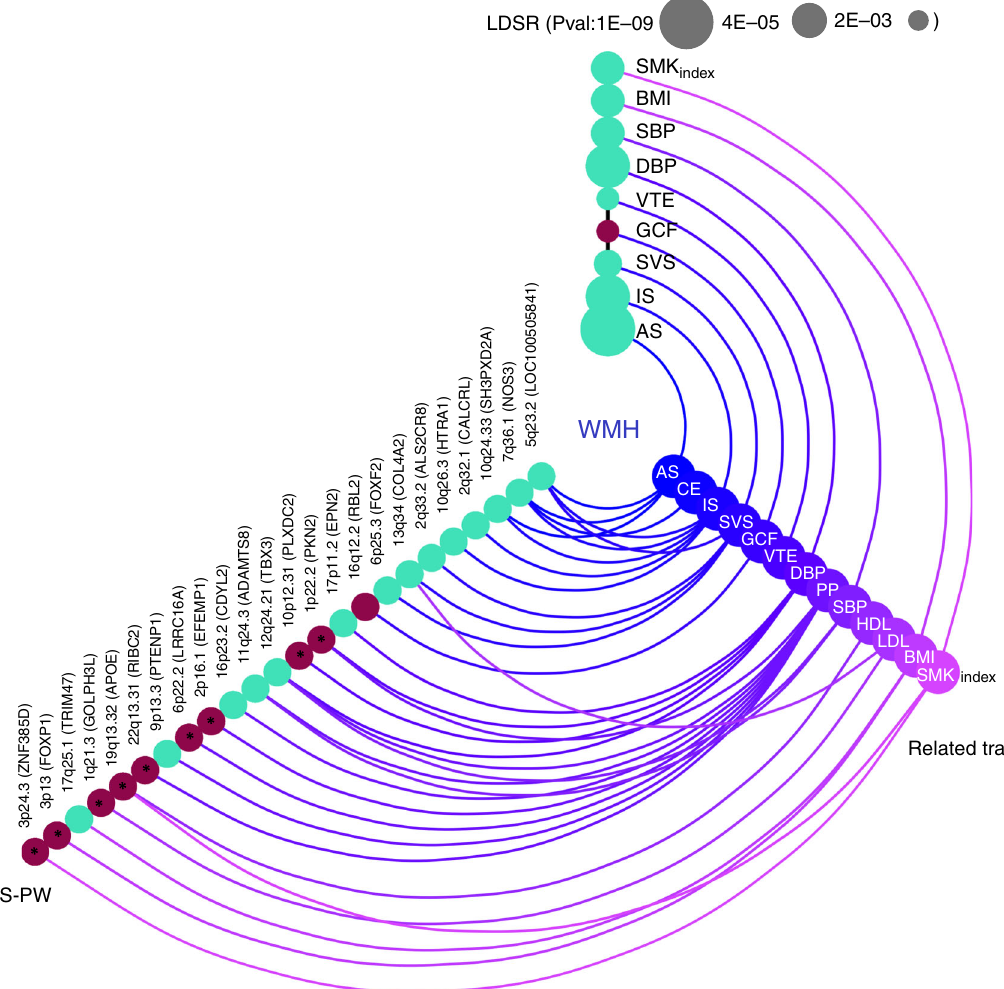
Fig. 3 Shared genetic architecture of WMH at genome-wide and regional level Color coded for the direction of effect (Green: Positive genetic correlation; Red: Negative genetic correlation). The LD-score regression (LDSR) axis shows evidence for genome-wide correlations (after Bonferroni correction for multiple testing P < 3.6 × 10 − 3 , Methods), with the size of the nodes corresponding to the level of signi fi cance of the association. The GWAS- pairwise (PW) axis shows evidence for regional level overlap of association signals between WMH burden and related vascular and neurological traits (PPA3 ≥ 0.90, Methods). For any given region, the nearest gene (in brackets) to the top SNP associated with WMH is shown. Bivariate heritability estimator from summary statistics ( ρ -HESS) was used to infer directionality of shared association signals (Methods) and asterisks denote an unexpected directionality of association. SBP systolic blood pressure, DBP diastolic blood pressure, PP pulse pressure, AS all stroke, IS ischemic stroke, SVS small vessel stroke, CE cardioembolic stroke, BMI body mass index, HDL high-density lipoprotein, LDL low-density lipoprotein, VTE venous